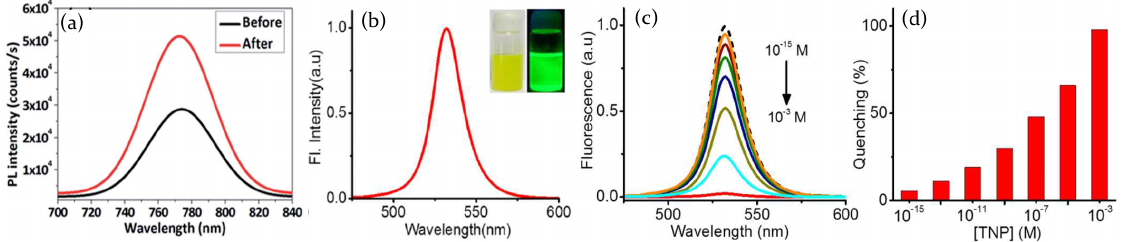
Figure 22. ( a ) Photoluminescence intensity of MAPbI 3 perovskite film before and after ethanol gas exposure. Adapted with permission from [7] under a Creative Commons Attribution-NonCommercial 3.0 Unported license. Copyright © 2020, Royal Society of Chemistry. ( b ) Emission spectrum of MAPbBr 3 nanoparticles. Inset: photographs of the nanoparticle suspension in toluene under room light (left, yellow colored) and 364 nm UV light (right, green colored). ( c ) Fluorescence spectra of MAPbBr 3 nanoparticles at an increasing concentration of TNP, ranging from 10 − 3 M to 10 − 15 M, with the ( d ) corresponding quenching percentage for the increasing TNP concentration. Used with the permission of the Royal Society of Chemistry, from [105]. Copyright © 2014. Permission conveyed through Copyright Clearance Center,